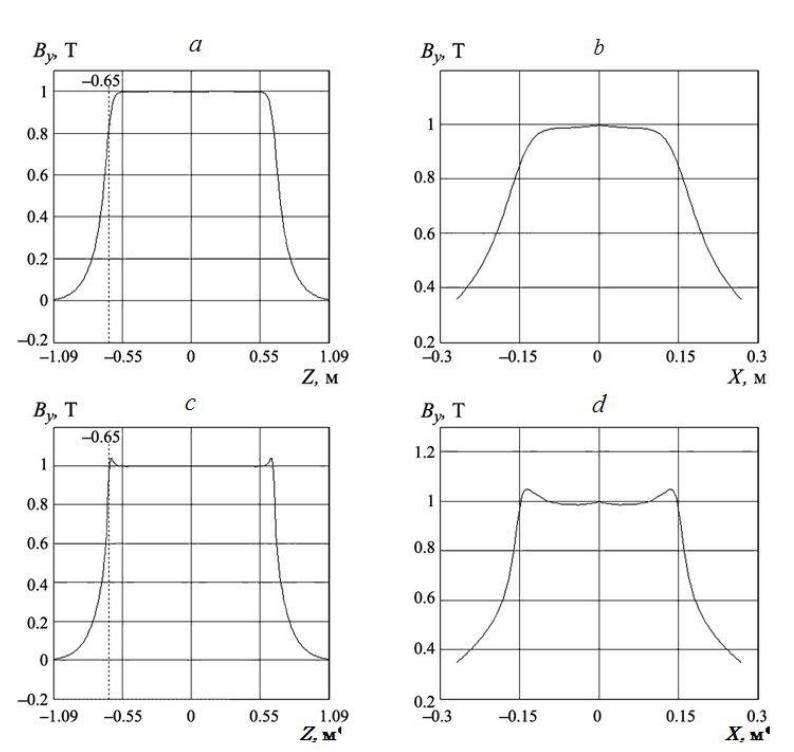
Figure 2. For a current I = 328 A: distribution B y ( x = 0 ,y = 0 , z ) for the median plane x = 0, y = 0 (a); distribution B y ( x ,y = 0 , z = 0) for the median plane y = 0, z = 0 (b); distribution B y ( x = 0 ,y = 4 cm , z ) for the plane y = 4 cm, x = 0 (c); distribution B y ( x ,y = 5 cm , z = 0) for the plane y = 4 cm, z = 0